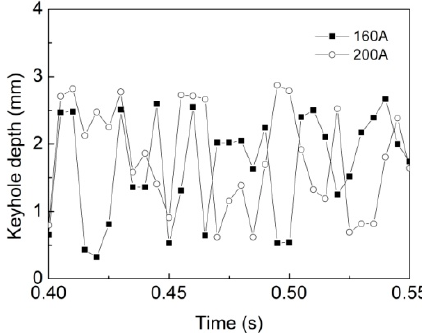
Figure 13. Evolution of the keyhole depth for different welding currents.